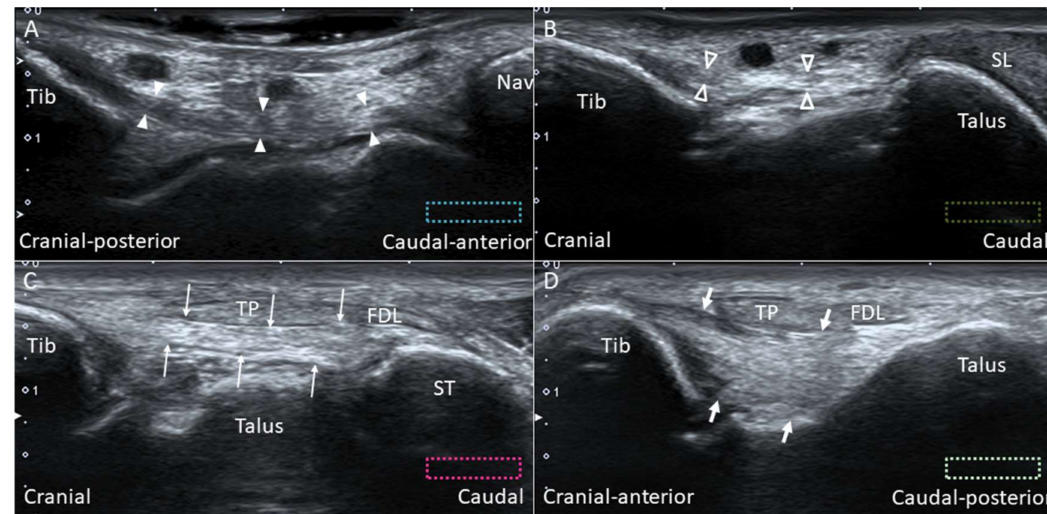
Figure 9. Imaging for the tibionavicular (white arrowheads) ( A ), tibiospring (void arrowheads) ( B ), tibiocalcaneal (thin arrows) ( C ) and tibiotalar (thick arrows) ( D ) ligaments. The colored dashed rectangles are in accordance with the transducer positions in Figure 3A. FDL: flexor digitorum longus tendon; Nav: navicular; SL: spring ligament; ST: sustentaculum tali; Tib: tibia; TP: tibialis posterior